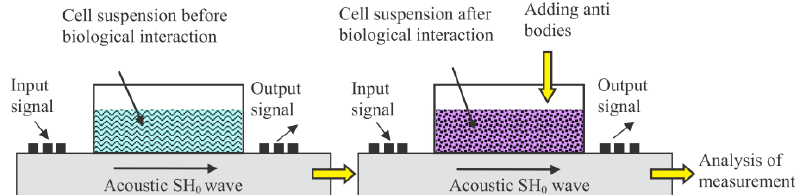
Figure 7. Schematic diagram of the electroacoustic measurements using an X–Y lithium niobate piezoelectric plate and target cell-specific M13 bacteriophage solution. Reproduced from [52], with permission from Elsevier, 2018.